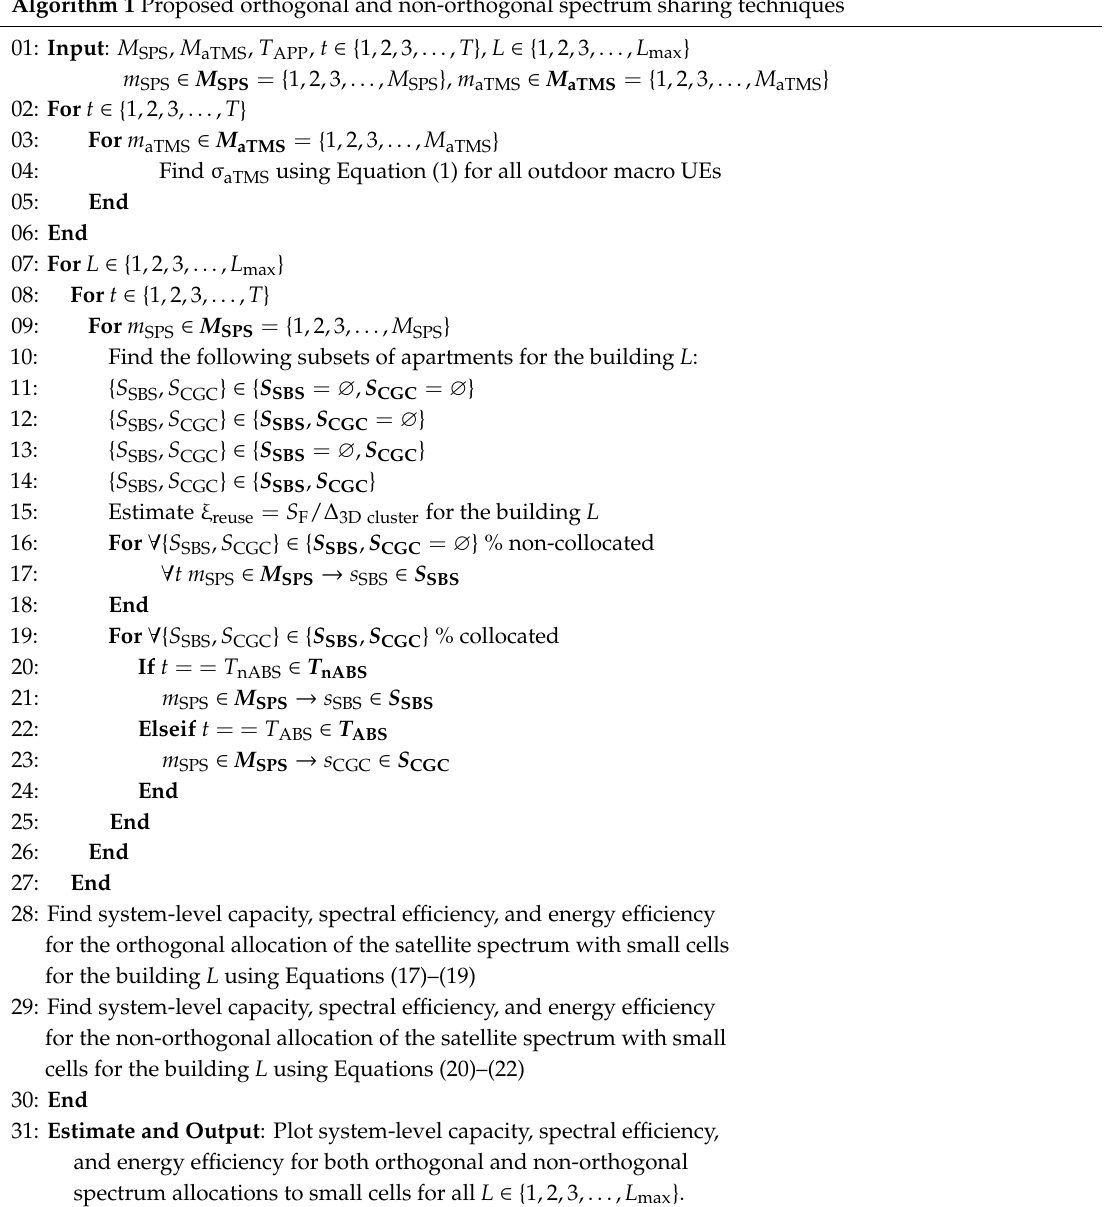
Algorithm 1 Proposed orthogonal and non-orthogonal spectrum sharing